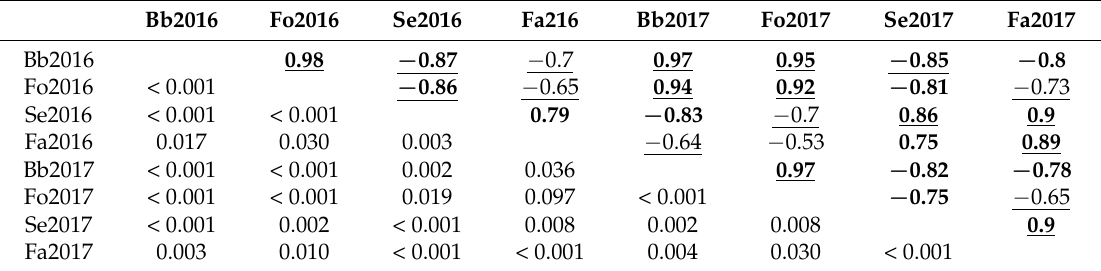
Table 6. Correlations between the timing of the four phenophases bud burst (Bb), flower opening (Fo), leaf senescence (Se) and leaf fall (Fa) in 2016 and 2017. Pearson correlation coefficients and corresponding p -values are indicated above and below the diagonal respectively. A correlation coefficient with a corresponding p-value below 0.001 is indicated in bold and is underlined, between 0.001 and 0.01 is in bold and between 0.01 and 0.05 is underlined.